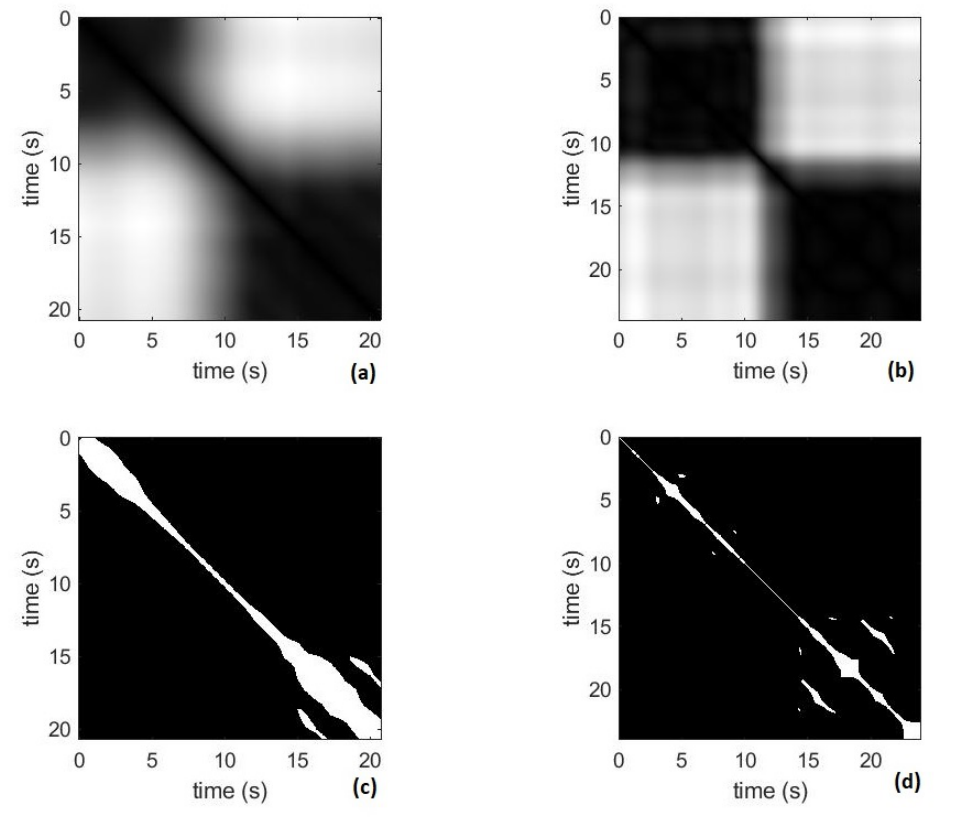
Figure 4. Recurrence matrices for the activities: ( a ) Si2St (m = 5, τ = 15, ρ = 0.01); ( b ) St2Si (m = 5, τ = 18, ρ = 0.04) before the step function; ( c ) Si2St; ( d ) St2Si after the step function. Several variables were used to quantify the structure present in the recurrence